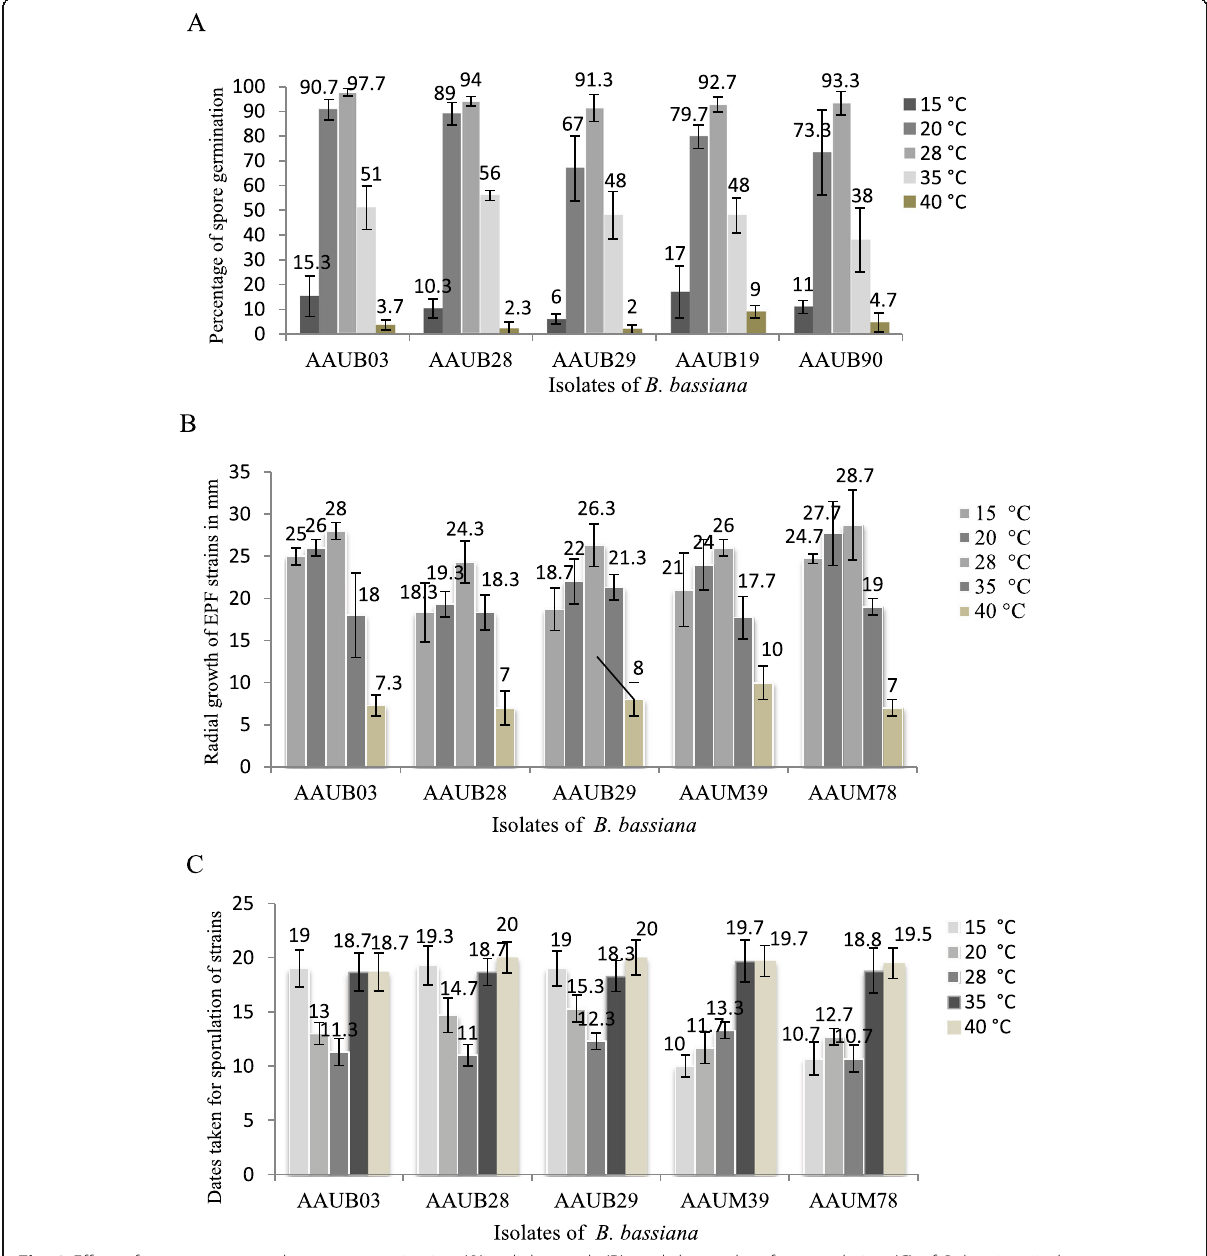
Fig. 3 Effect of temperature on the spore germination ( A ) radial growth ( B ), and dates taken for sporulation ( C ) of B. bassiana